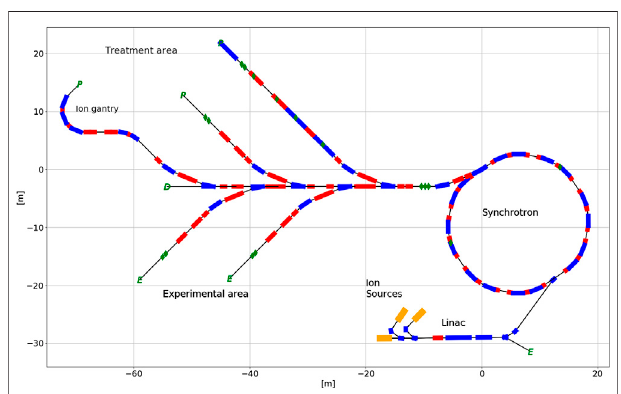
FIGURE 4 | A preliminary layout of the SEEIIST facility. The upper beamlines are dedicated to patient treatment while the lower ones are dedicated to radiobiology and materials